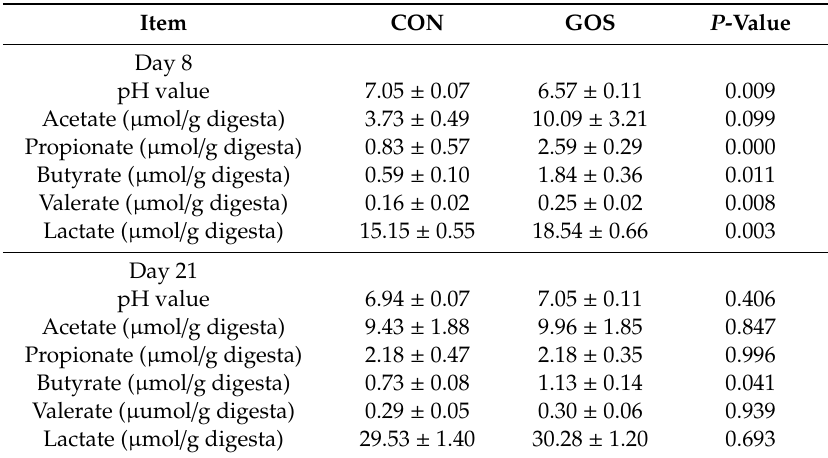
Table 1. Ileal pH value and concentrations of short-chain fatty acids (SCFAs) and lactate in ileal digesta of piglets on the day 8 and day 21 a .